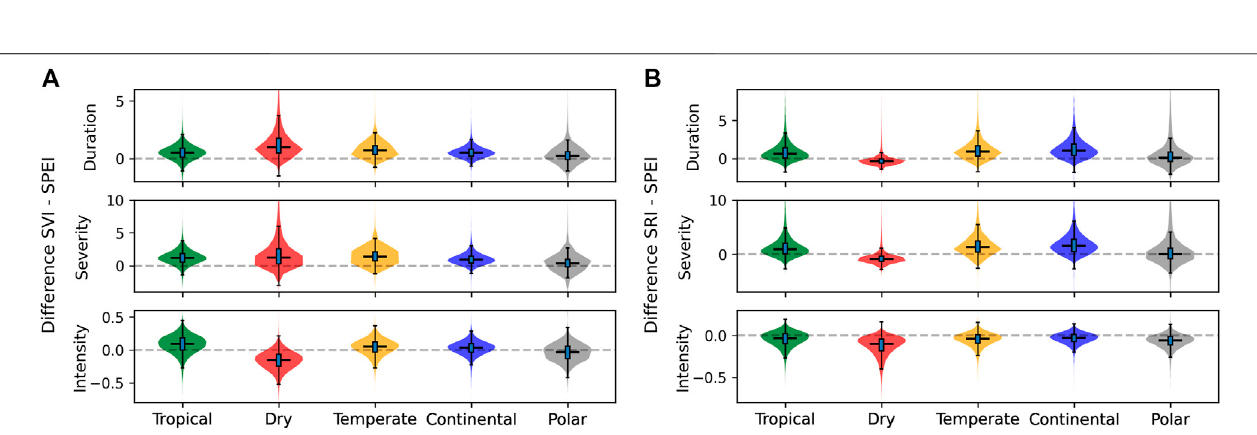
FIGURE 14 | Differences of drought characteristics between SVI and SPEI (A) and between SRI and SPEI (B) for major Köppen climate groups.